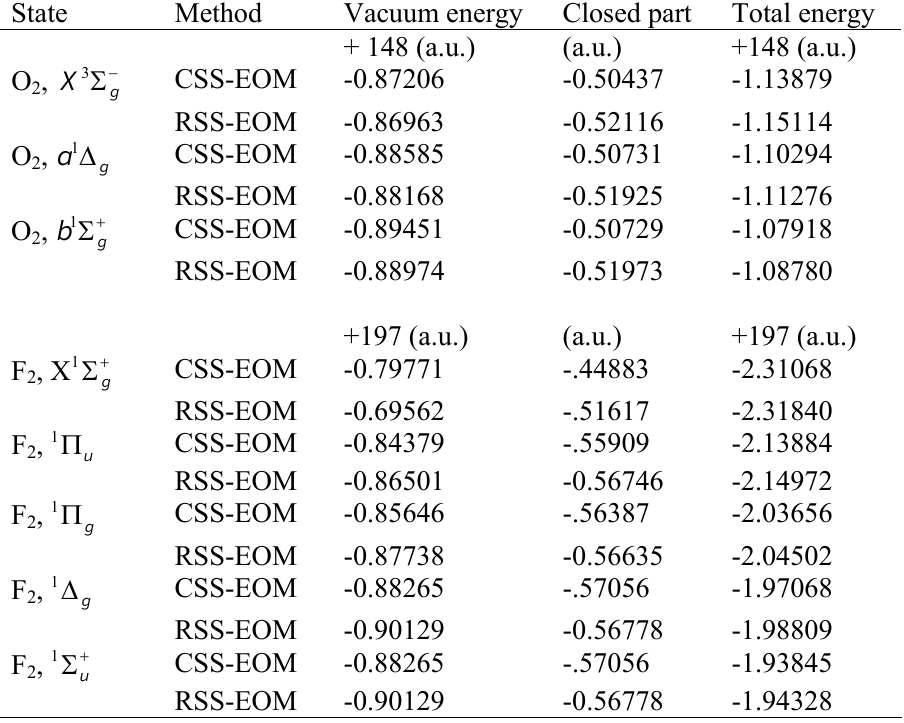
Table VII. Partitioning of various energy terms and total energies for the O the F molecule at R=141.36 pm in the cc-pVTZ basis 2